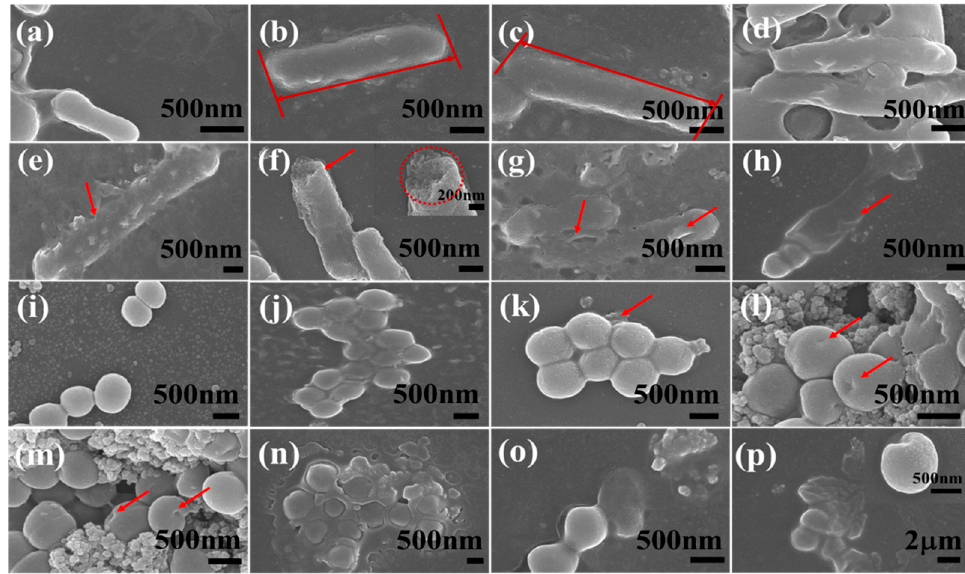
Figure 5. Time-dependent SEM images of E. coli ( a – h ) and S. aureus ( i – p ) treated with Fe 3 O 4 /Pd/mpg- C 3 N 4 nanocomposites (100 μ g/mL) under solar light illumination. ( a , i ) 0 min, ( b , j ) 15 min, ( c , k ) 30